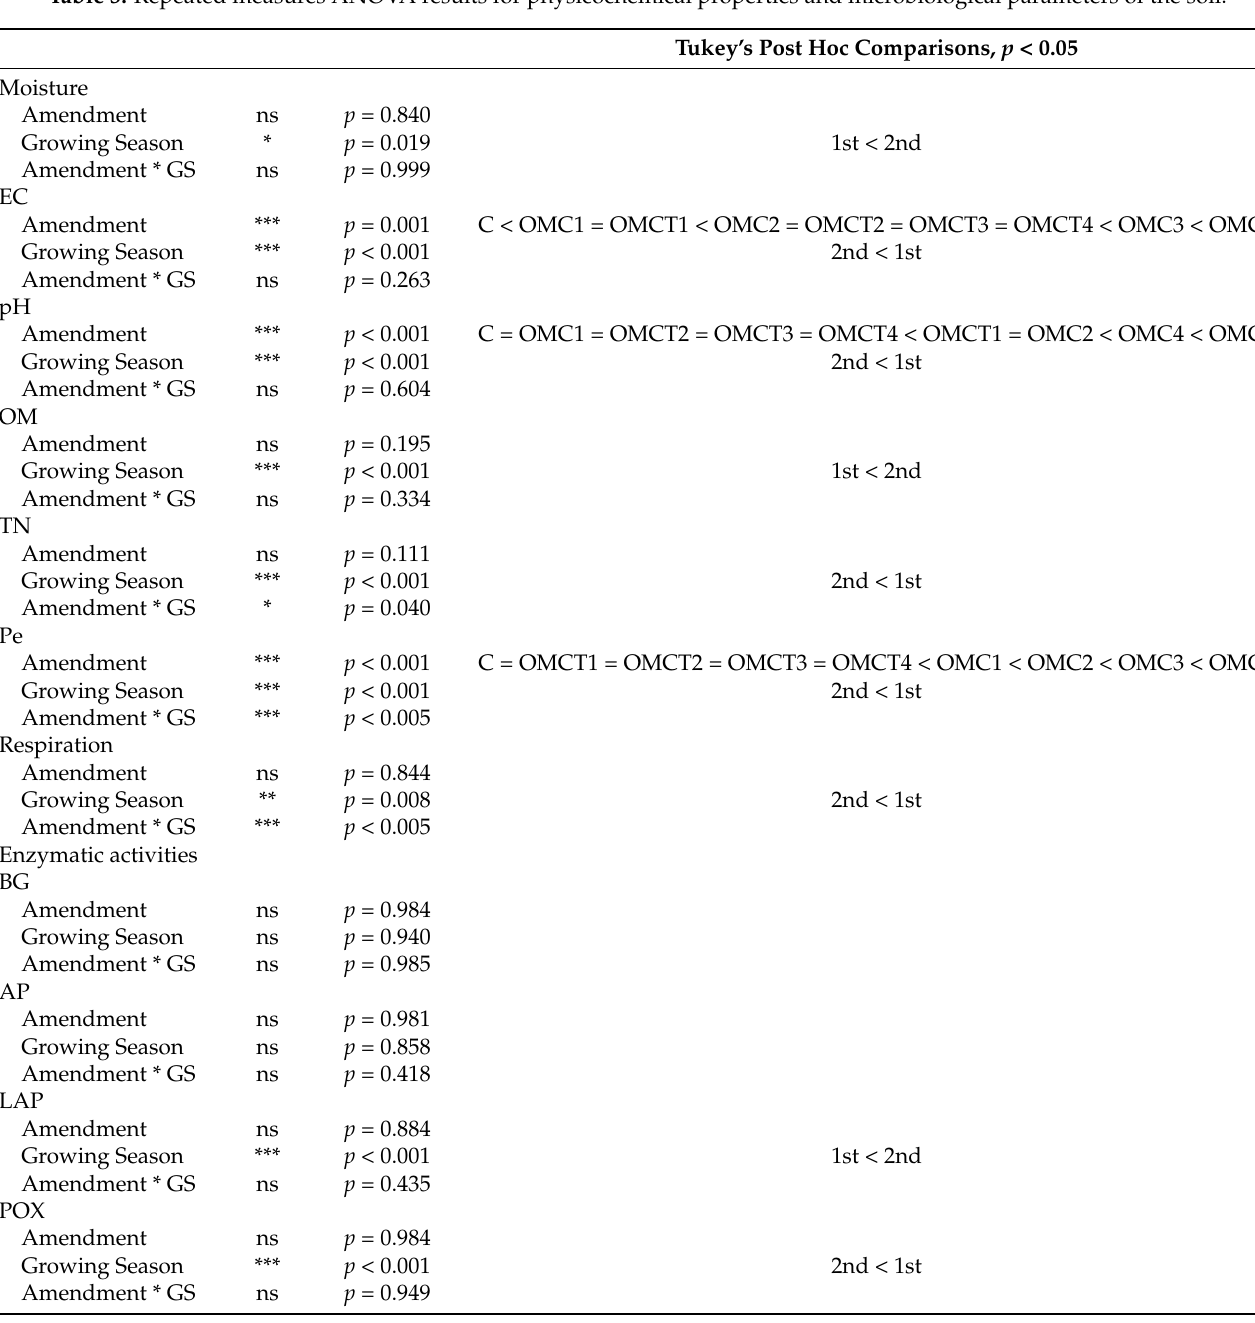
Table 3. Repeated measures ANOVA results for physicochemical properties and microbiological parameters of the soil. Tukey’s Post Hoc Comparisons, p <